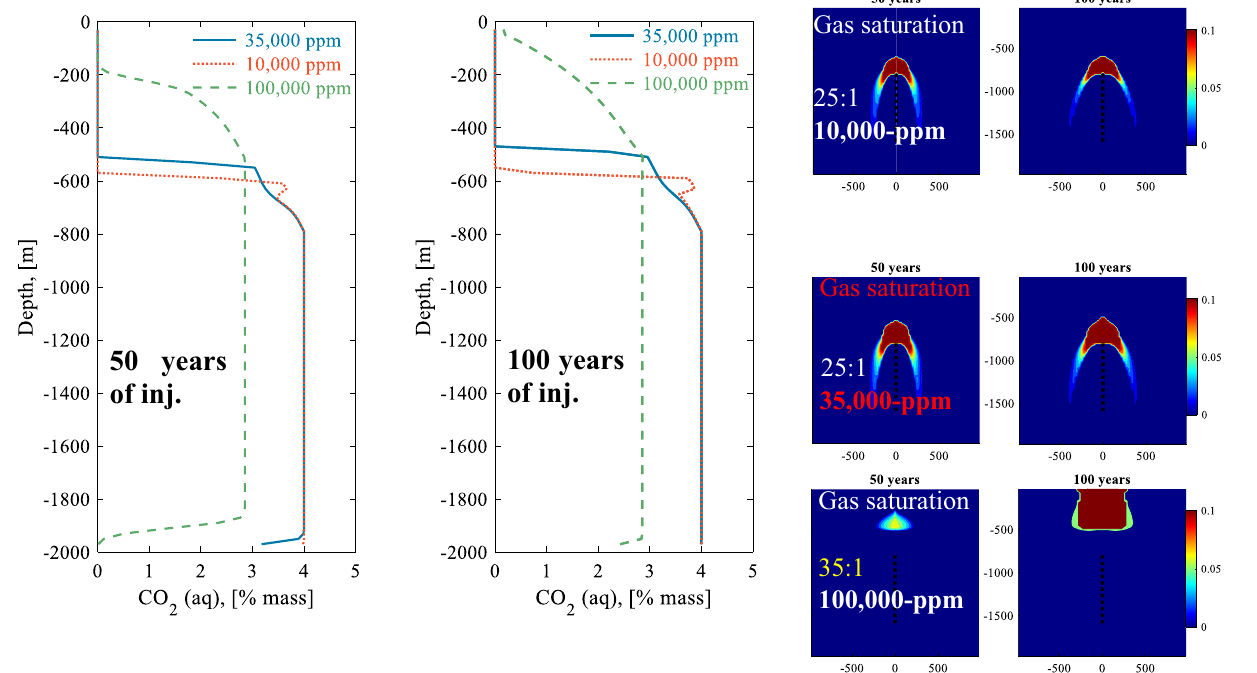
Figure 5. Left and center plots: Comparison of CO 2 concentration profiles at the well versus depth after 50 and 100 years of injection for the injection of CO 2 charged water having a seawater salinity with into reservoirs having an initial salinity of 10,000, 35,000 (the reference case), and 100,000 ppm. The injection water to CO 2 mass ratio is 25:1 for the 10,000 and 35,000, ppm initial salinities, and 35:1 for the 100,000 ppm initial salinity. Right plots: 2D cross-sections for the gas saturation, which is the mass fraction of exsolved CO 2 in the pore fluids, for the three salinities after 50 and 100 years of carbonated water